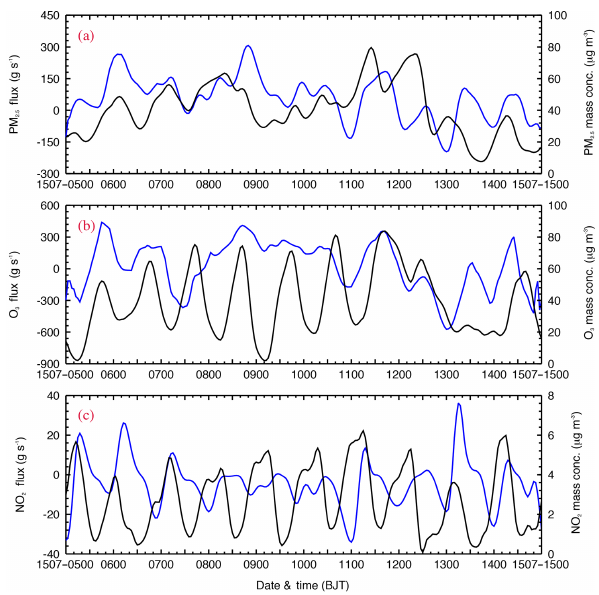
Figure 9. Temporal variations of total net horizontal transport flux of PM 2 . 5 , O 3 , and NO 2 over the Beijing boundary (blue line) and the contribution of non-Beijing emission to the PM 2 . 5 , O 3 , and NO 2 concentrations in Beijing (black line) during the study episode.